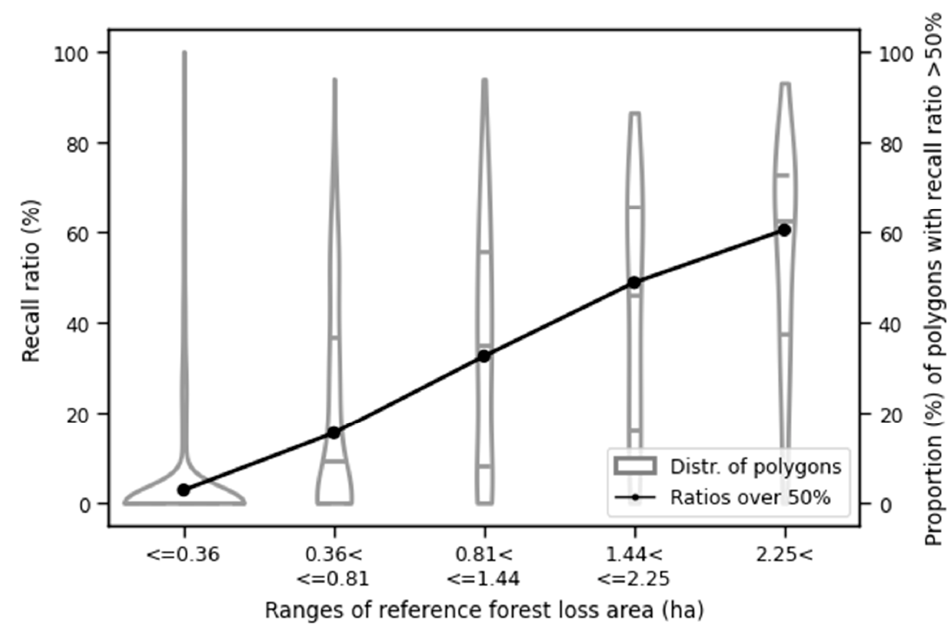
Figure 8. Comparison of violin plots of the distributions of recall ratios for forest-loss polygons in the reference dataset in five size ranges. Dashed horizontal lines show quartile and median values. For each size range, the black dots mark the proportion of forest-loss polygons successfully being detected (recall ratio > 50%) in the reference dataset.